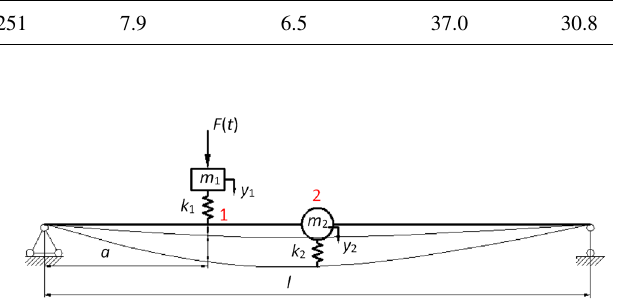
Fig. 5 Dynamic model of single pumping